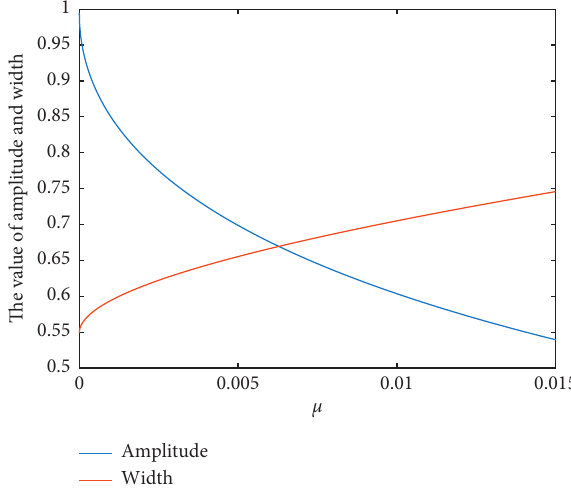
Figure 1: Variation of amplitude and width according to